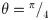
A sample of f(x) results for (a) θ=π4 and (b) θ=π3.